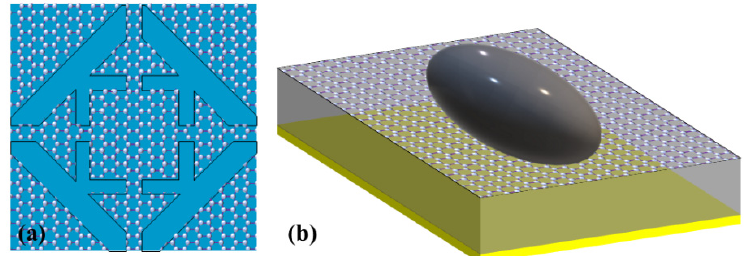
Figure 6. Graphene-based broad-band terahertz metamaterial absorbers. ( a ) structure designed by J. Z. Han et al. [78]; ( b ) a Si semi-ellipsoidal structure on a single-layer graphene film [83].